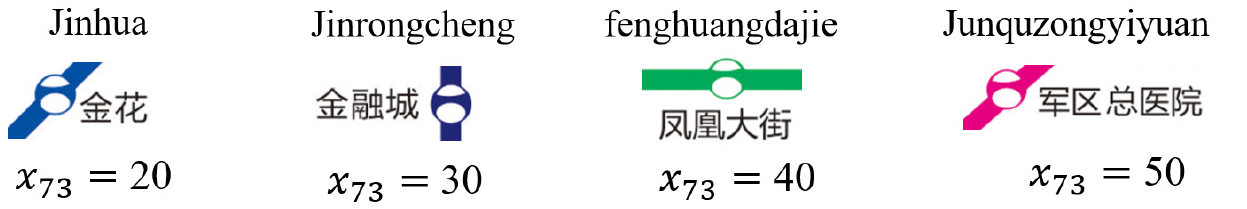
Figure 6. Name labels with different lengths from schematic Chengdu metro map.